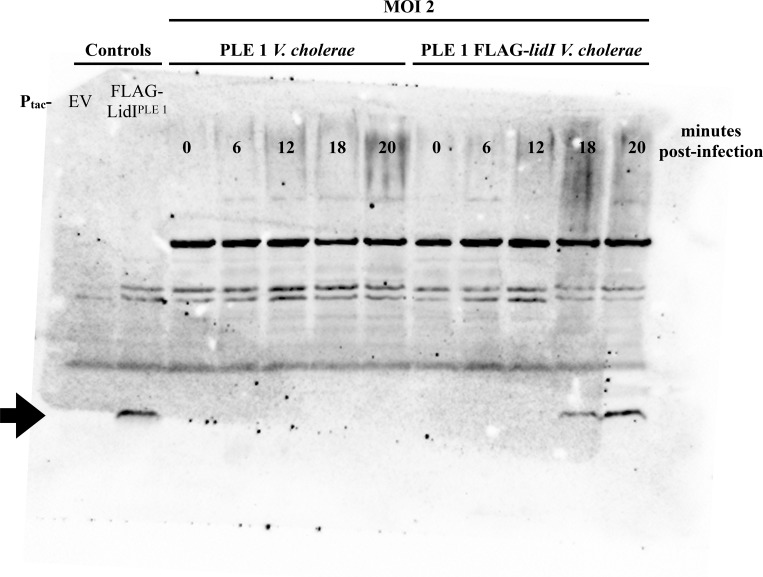
Complete Western Blot.Tagged LidIPLE 1 was visualized via western blot. EV and FLAG-LidIPLE 1 expressed in trans served as controls showing FLAG-LidIPLE 1 specificity as well as the presence of background bands. In PLE 1 V. cholerae, there is no detectable band similar in size to tagged LidIPLE 1 (as indicated by the arrow). When LidIPLE 1 is tagged in the native locus and strains are infected with ICP1, FLAG-LidIPLE 1 is visible late in infection (18 and 20 minutes post-infection).